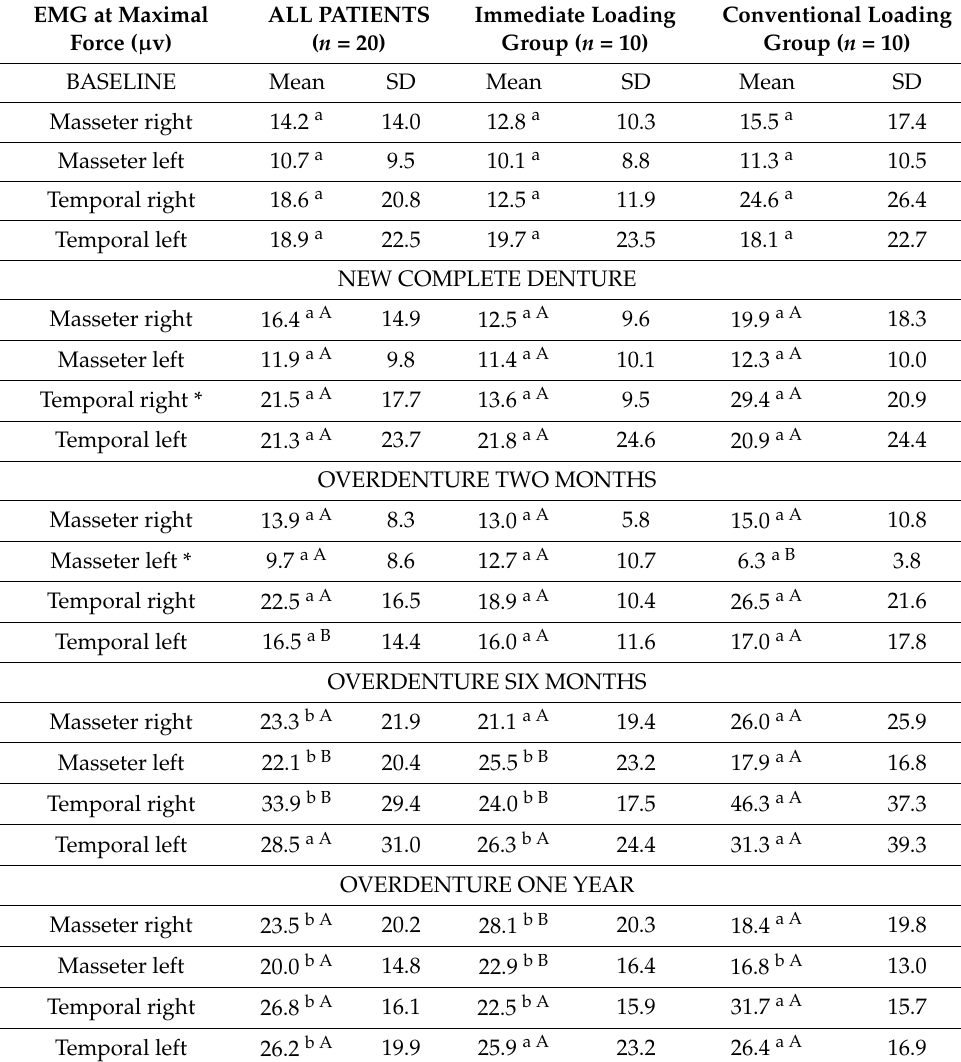
Table 5. Changes in the electromyographic records ( µ v) after prosthetic treatments ( n = 20). EMG at Maximal ALL Force ( µ v)